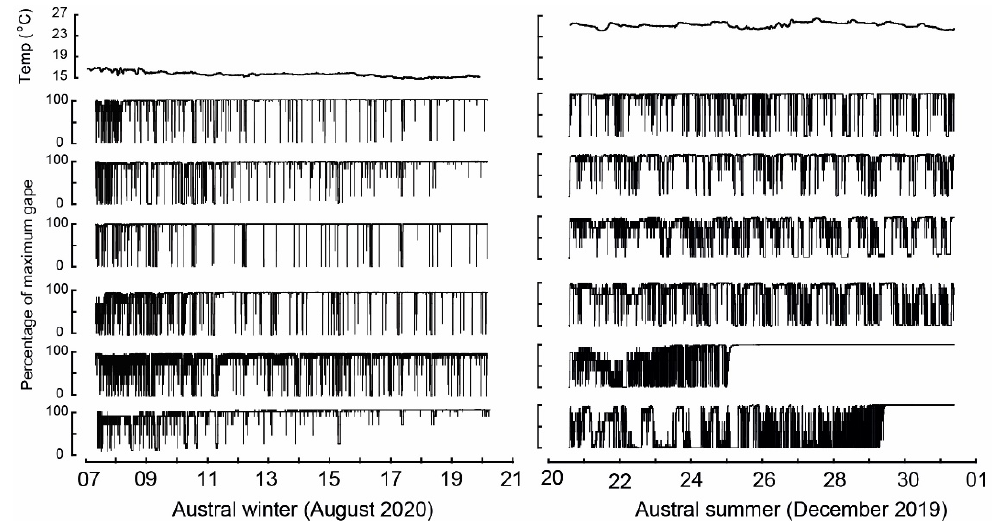
Figure 6. Temperature (top graphs) and valve gape activity of six Mytilus galloprovincialis in the